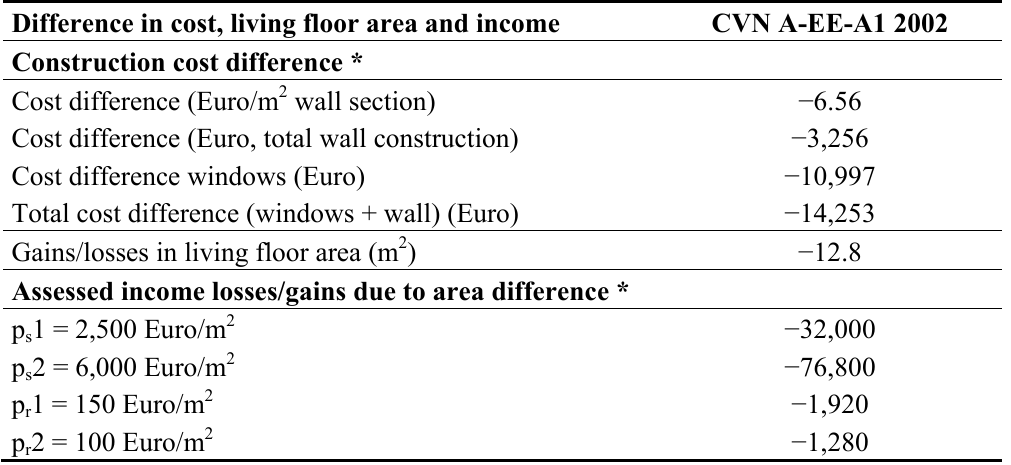
Table 5. Cost difference and assessed living area lost between conventional and energy-efficient building constructed in 2002, timber